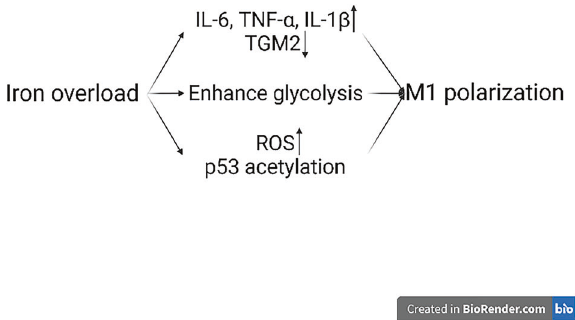
Fig. 5 Iron overload induces M1 polarization. Iron accumulation in macrophages promotes M1 polarization in three main ways. M1 markers such as IL-6, TNF- α and IL-1 β increase and M2 markers like TGM2 decrease. Iron overload can enhance glycolysis and cause